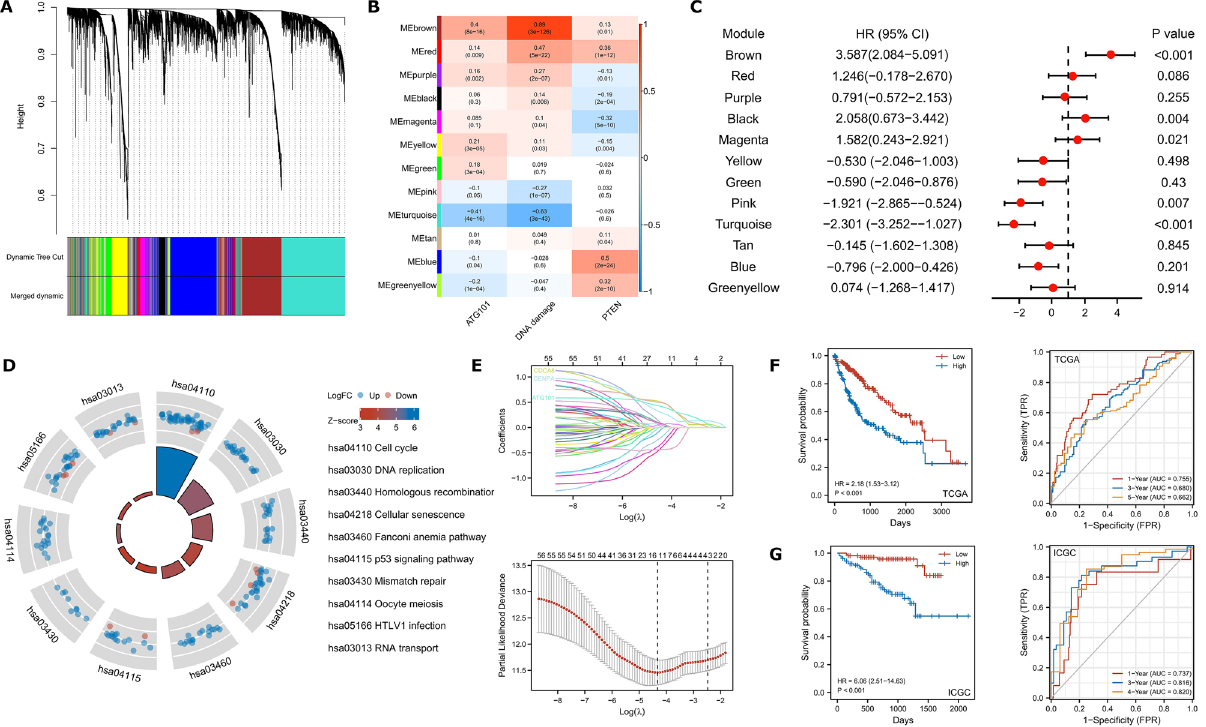
Figure 3. Establishment of an ATG101-related gene signature. ( A ) Modules were determined using WGCNA network. ( B ) Module-trait heatmap. ( C ) A forest plot depicting the prognosis of ME from each module. ( D ) KEGG enrichment of the brown module. ( E ) LASSO coefficient profiles of the expression of 51 candidate genes (upper panel), and the selection of the penalty parameter (λ) in the LASSO model (bottom panel). ( F , G ) Kaplan–Meier curves and time-dependent ROC plot of ATS in TCGA and ICGC cohorts,